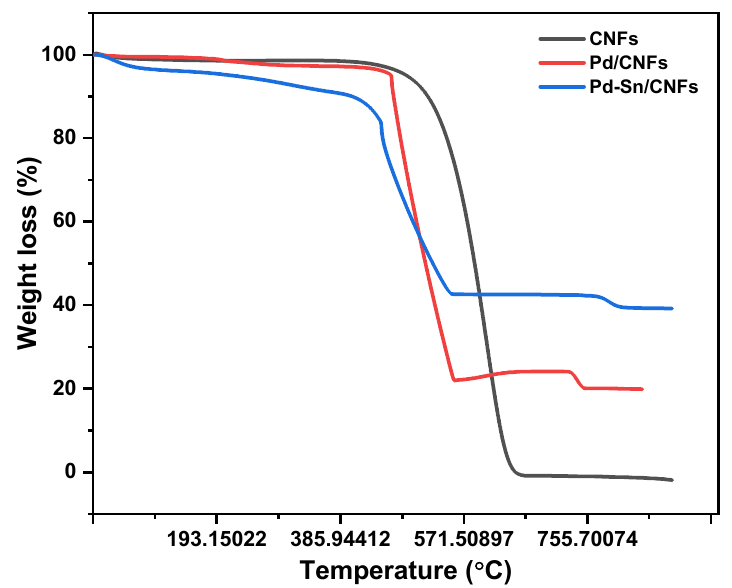
Figure 6. TGA profiles of CNFs support, Pd/CNFs and Pd-Sn/CNFs electro-catalysts.